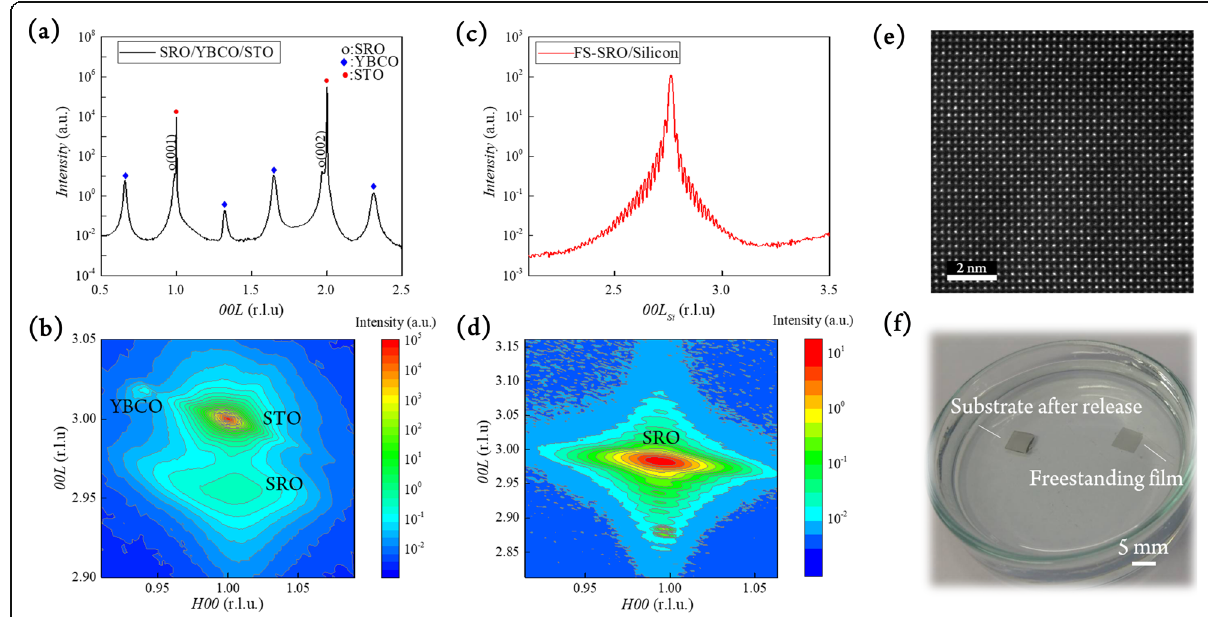
Fig. 5 a XRD normal scan and b RSM of as-grown SRO heterostructure. c XRD normal scan and d RSM of freestanding SRO. e Plane view STEM HAADF image of freestanding SRO. f Photograph of freestanding SRO film and substrate after